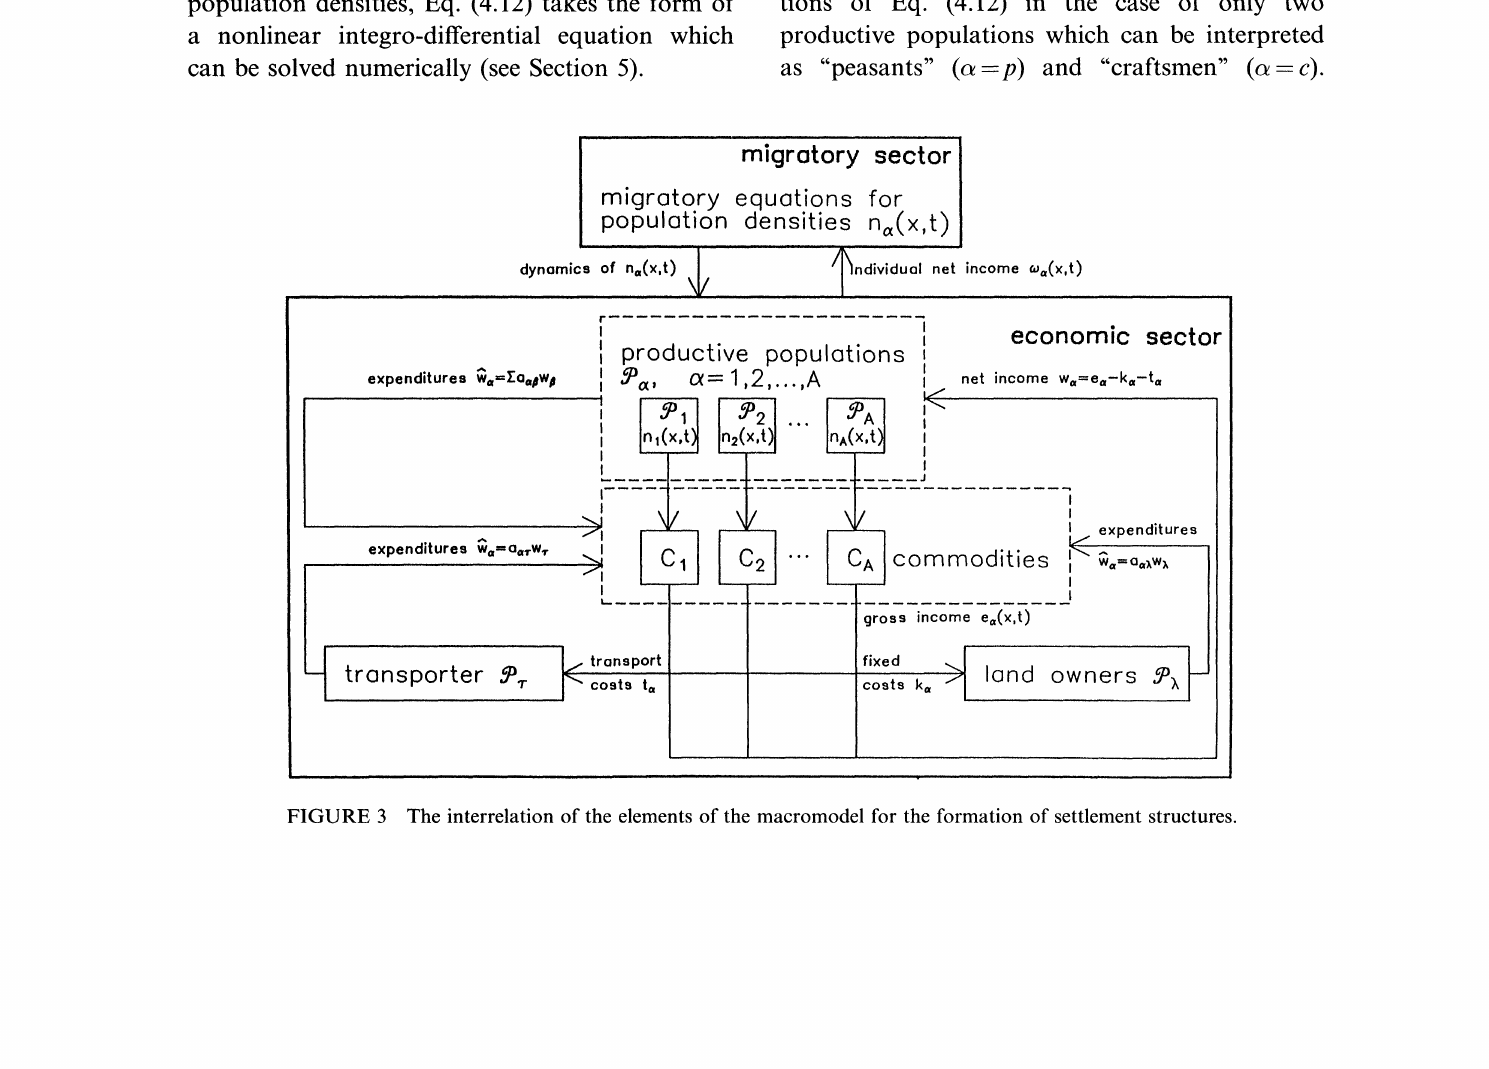
FIGURE 3 The interrelation of the elements of the macromodel for the formation of settlement